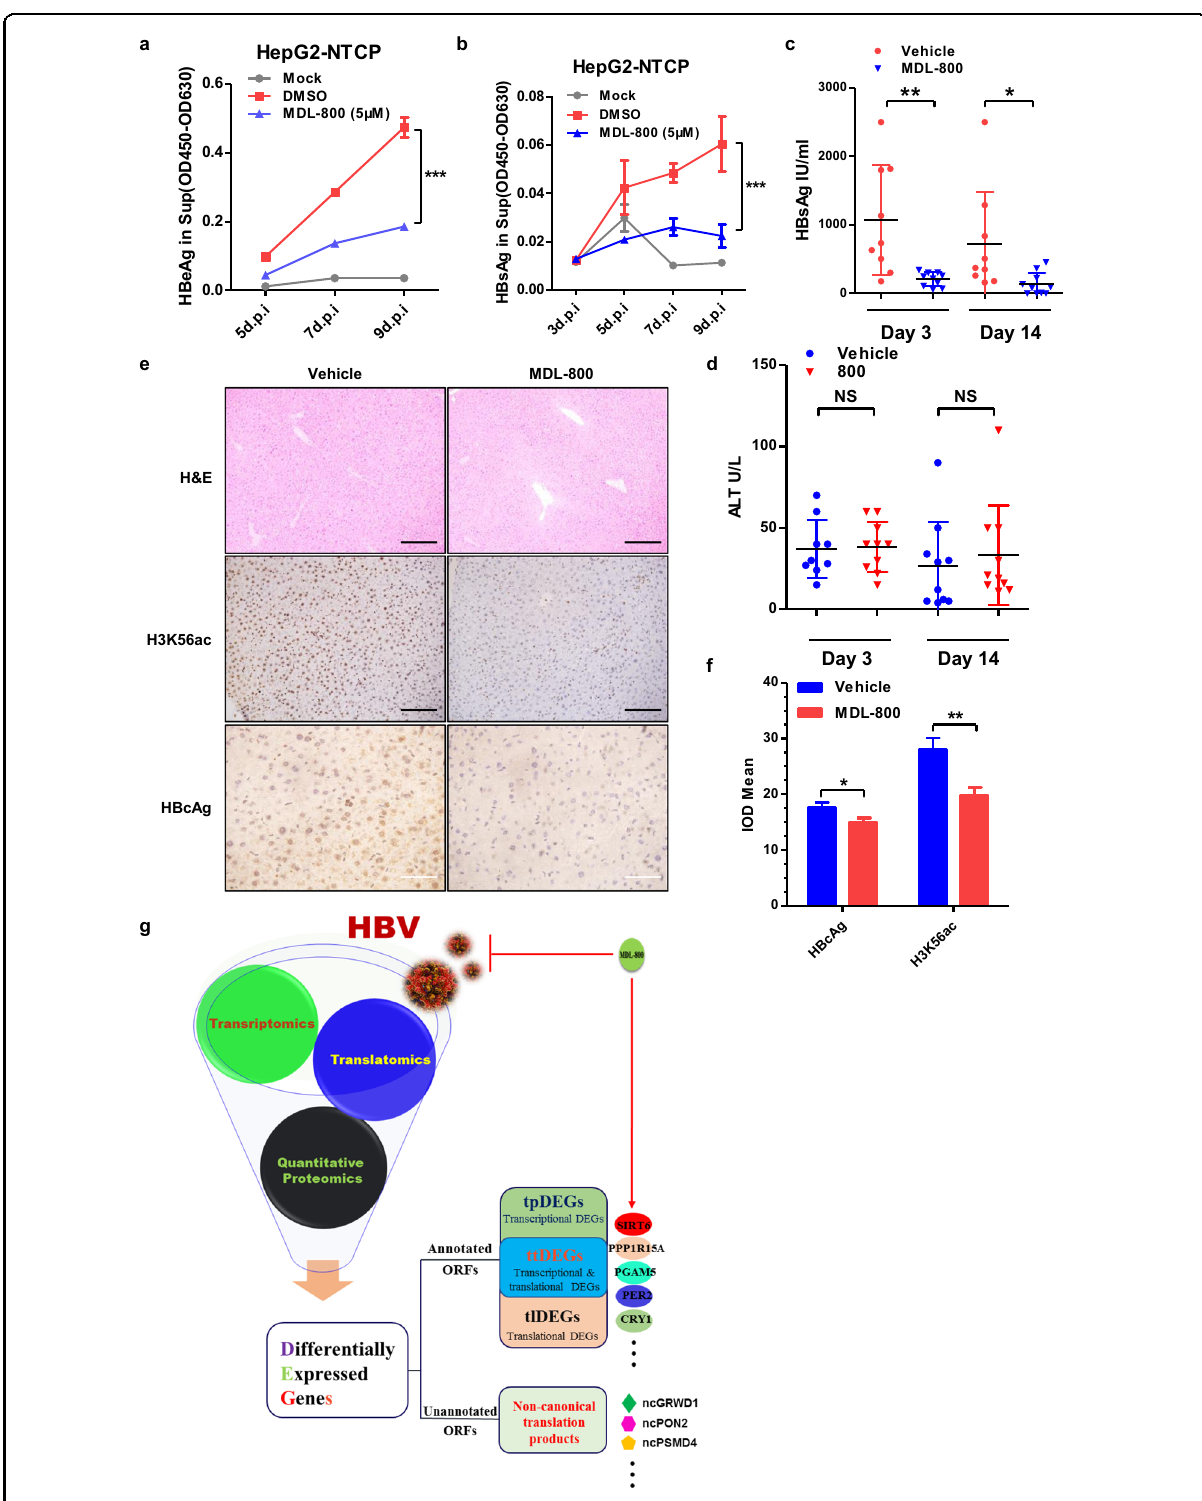
Fig. 6 (See legend on next